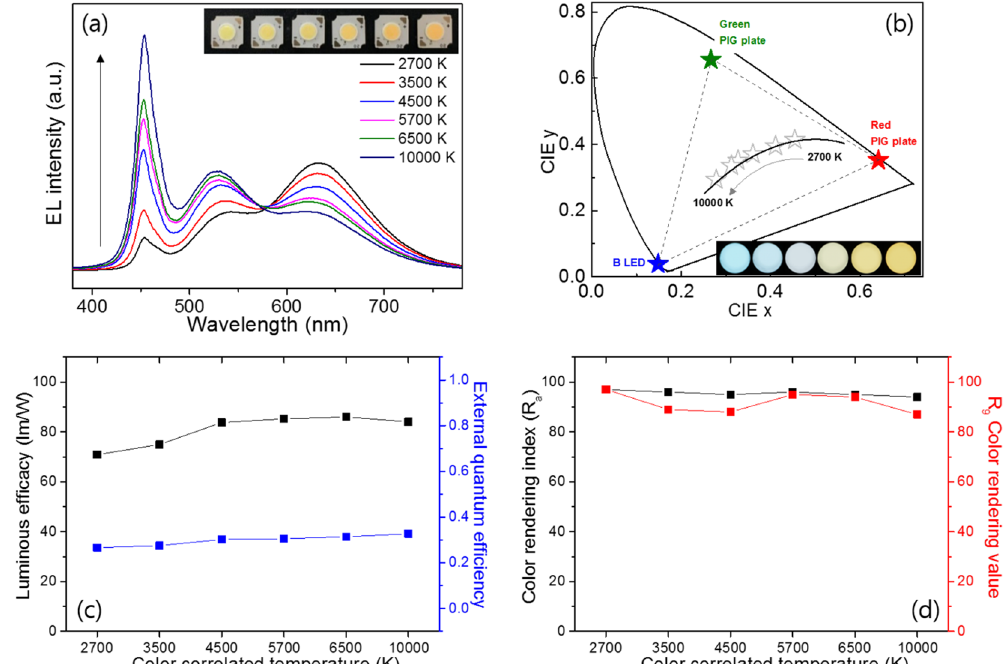
Figure 6. ( a ) EL spectra and ( b ) CIE color coordinates of the PIG-based on-chip COB WLEDs in the white CCT range of 2700 K and 10000 K. Insets: ( a ) actual photographs and ( b ) emission images of the fabricated PIG- based on-chip COB WLED with a decrease in the CCT from left to right. The black arrow indicates the increase in the CCT. ( c ) LE, EQE and ( d ) CRI (R a ), and R 9 diagrams of the PIG-based on-chip COB WLEDs.